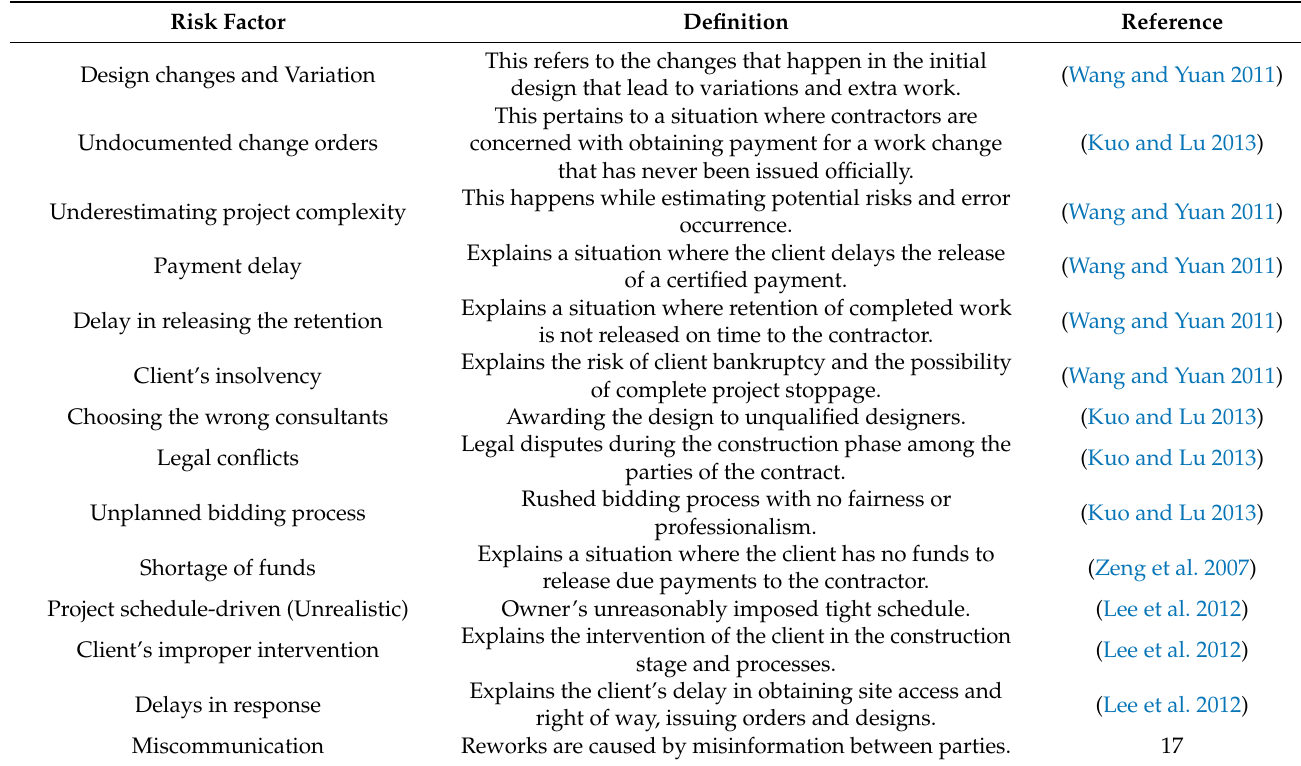
Table 1. Risk factors related to cash flow forecasting attributed to